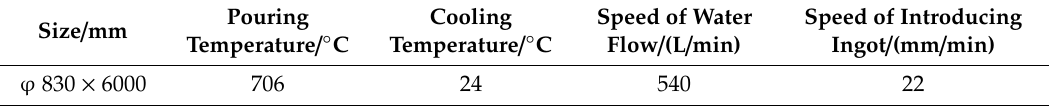
Figure 2. 2A14 aluminum alloy ultrasonic semi-continuous casting: ( a ) schematic diagram of casting; ( b ) photo of casting site; and ( c ) ingot product. Table 2. Casting process parameters of the 2A14 aluminum ingots.